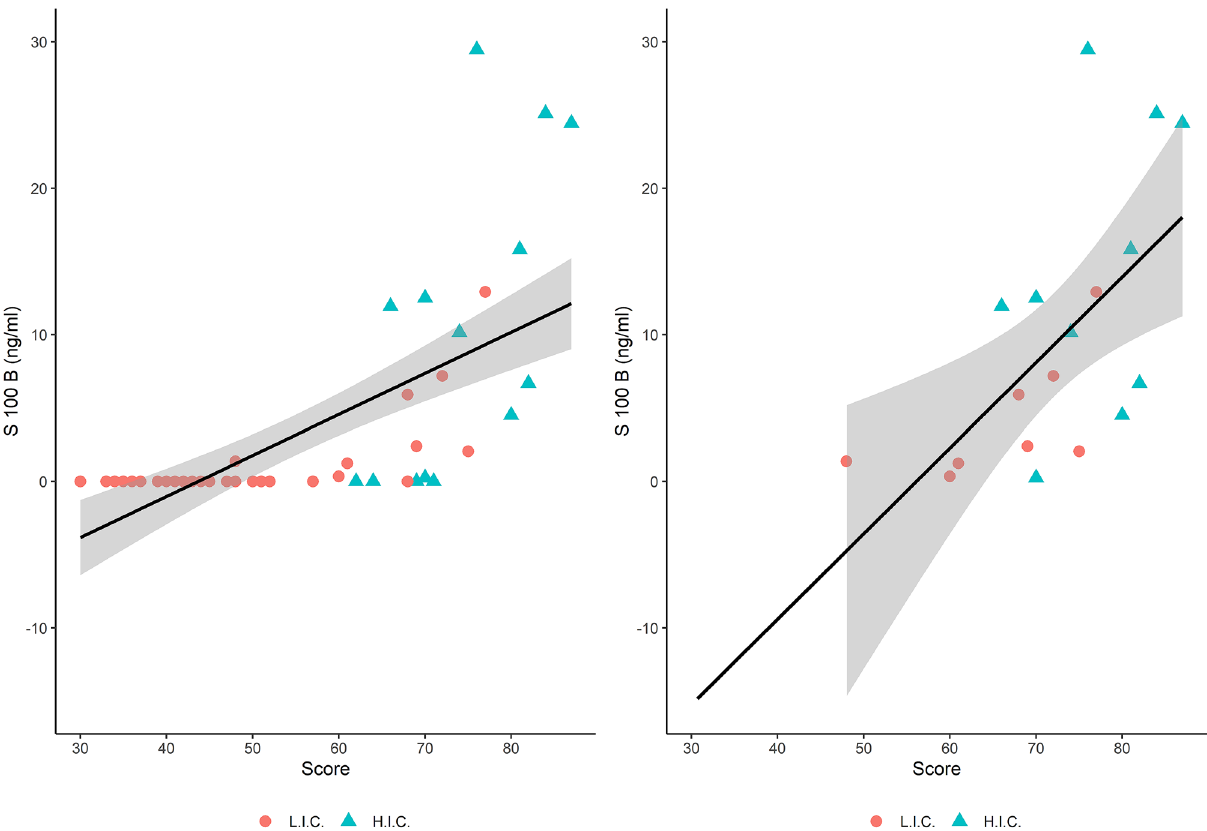
Figure 2. Relationship between Covid-Score and concentration of S100B. The scatterplot shows a positive correlation between S100B concentration (ng/mL) and clinical severity of the disease as represented by Covid- score. Analysis considering all samples ( A ) or only those with S100B detected in serum ( B ), from both HIC and LIC wards. Most of the samples with a concentration of S100B below the LOD belongs to the group hospitalized in the LIC wards ( A ). When considering only patients with S100B over the LOD and from both wards ( B ), the regression equation was Y = 0.584X−32.778. Figure A is reported as a comparison respect to figure B to highlight the distribution of S100B levels below the LOD and the independent linear regression curves are reported in supplementary materials (S1). The hospitalization ward is indicated for each patient (Red Dots: Low Intensity Care (LIC); Blue Triangles: High Intensive Care (HIC). The linear regression lines and their confidence intervals (95%) are showed by the gray areas. The correlation between Covid-Score and S100B is equal to 0.66 ( p < 0.001) ( A ) and 0.61 ( p < 0.01) ( B